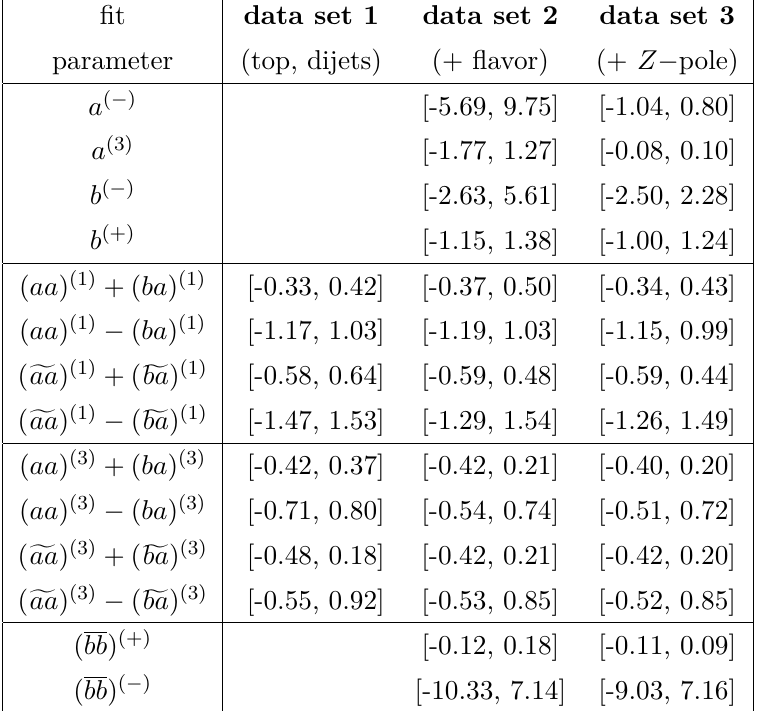
Table 1 . Bounds on individual fit parameters from three separate fits of LHC, LEP and flavor data to 8 parameters (data set 1) and 14 parameters (data sets 2 and 3). The intervals correspond to ∆ χ 2 = 3 . 84 , obtained by profiling the global likelihood over all remaining parameters in the fit. The results are presented in the basis eq.